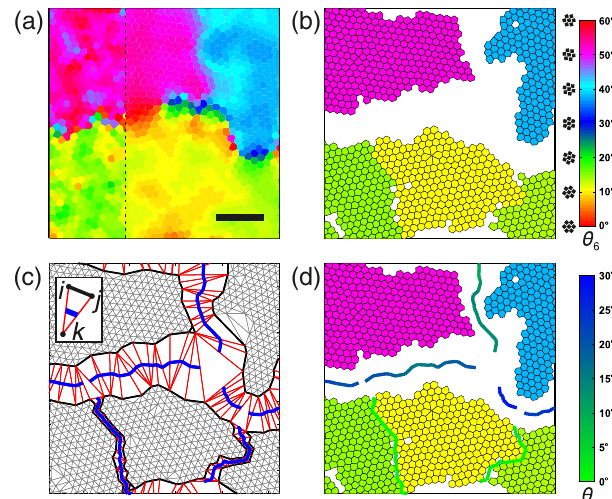
~ θ 6 . The ~ θ 6 of the